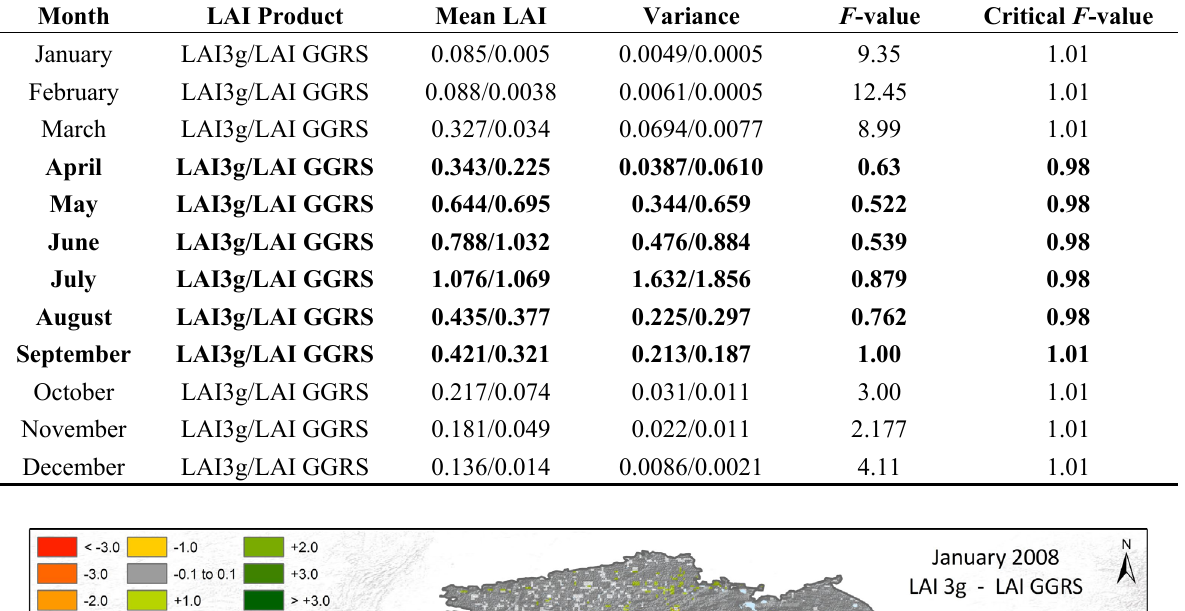
Table 6. Test statistics and results of the F -test carried out for a comparison of the LAI3g versus the LAI GGRS product. The number of samples used for the comparison is 48,000. The null hypothesis is accepted for marked months ( F -value < critical F -value).